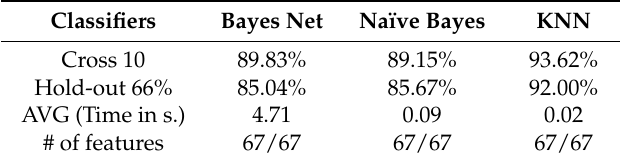
Table 5. Results using all features for Secure Password DB